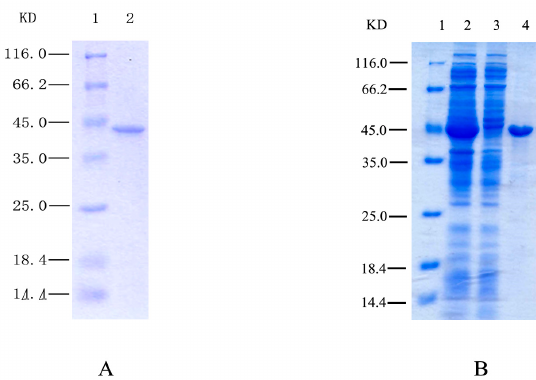
Figure 1. ( A ) SDS ‐ PAGE of the purified native HSPH ZZ from Pseudomonas sp. ZZ ‐ 5. Lane 1, molecular weight standards; Lane 2, superdex ‐ 200 gel filtration chromatography product (purified enzyme); ( B ) SDS ‐ PAGE of the purified recombinant HSPH ZZ from Pseudomonas sp. ZZ ‐ 5. Lane 1, molecular weight standards; Lane 2, crude cell extract; Lane 3, supernatant after centrifugation; Lane 4, supernatant after centrifugation; HSPH ZZ after nickel affinity chromatography.